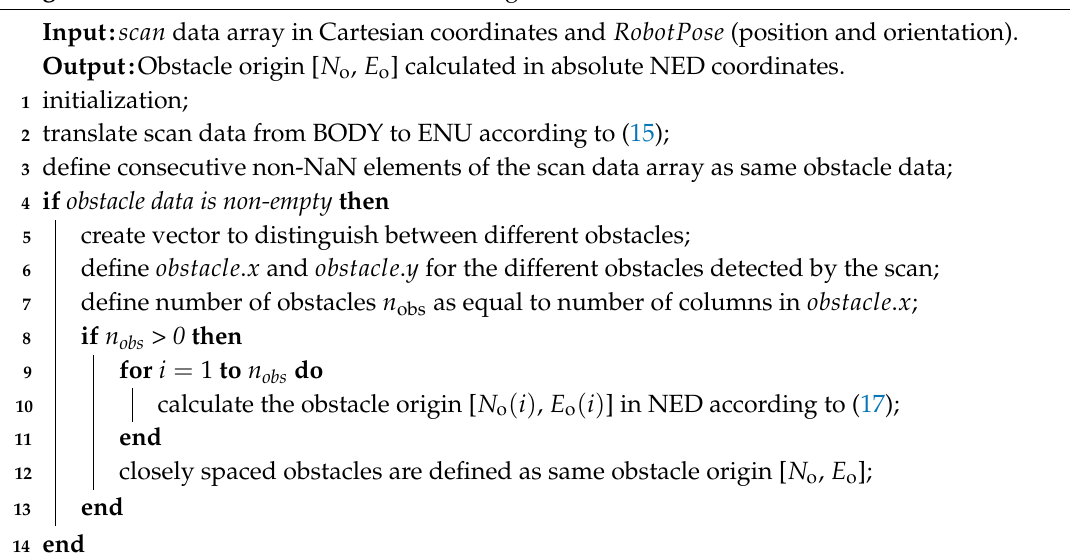
Algorithm 2: Localization of the detected targets.